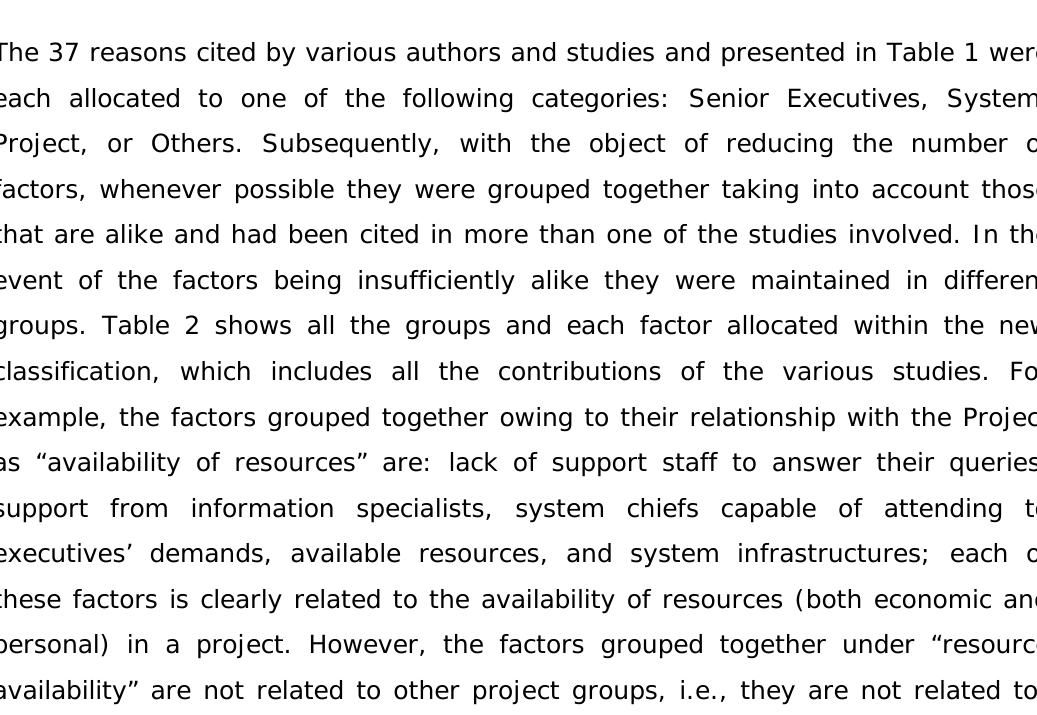
Table 1. “Summary of reasons against, reasons in favour of, and factors to increase the use of computers and applications by senior